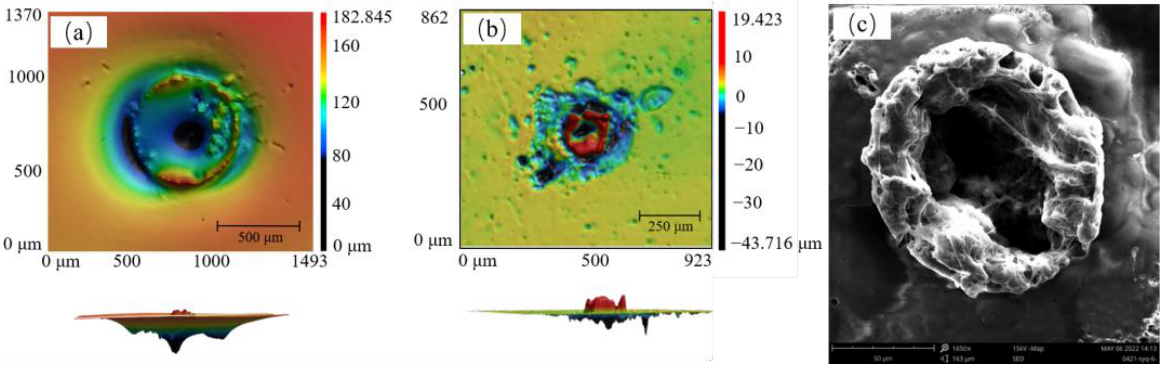
Figure 2. The ablation crater morphology of agarose hydrogel ( a ) and agarose film ( b ); SEM image of ablation crater morphology on agarose film ( c ).